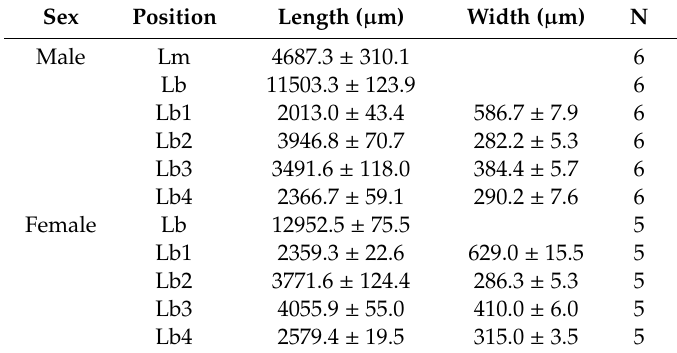
Table 1. Measurements of labrum and labium (mean ± SE) obtained from scanning electron microscopy. N = sample size. Lm, labrum; Lb, labium; Lb1, first segment of labium; Lb2, second segment of labium; Lb3, third segment of labium; Lb4, fourth segment of labium.